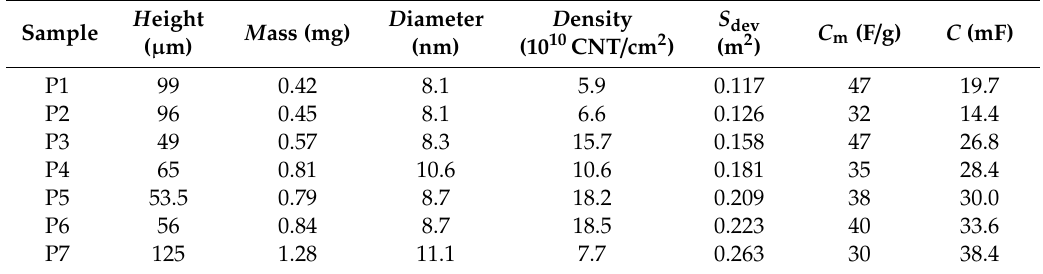
Table 1. VACNT characteristics and capacitance of VACNT-based